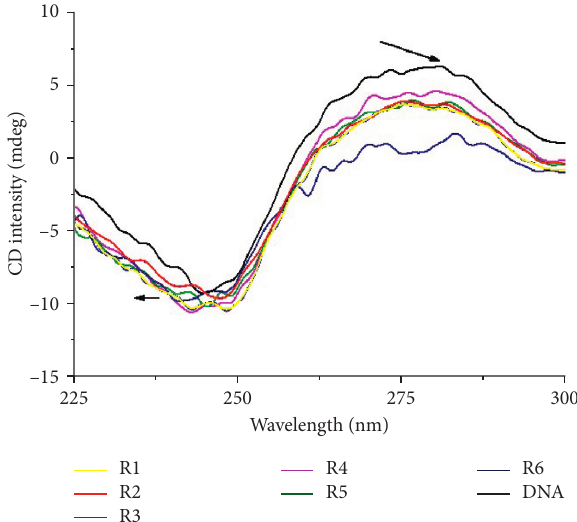
Figure 4: CD spectrum of DNA in the presence of complex 2.